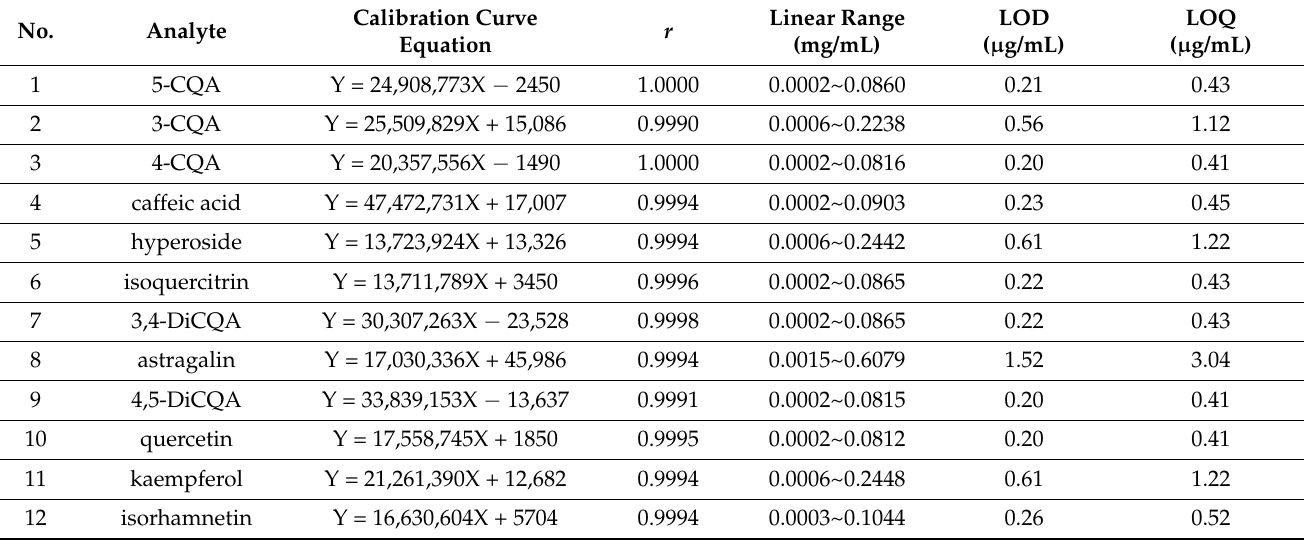
Table 2. Calibration curve equations, linear ranges, LODs, and LOQs of the bioactive